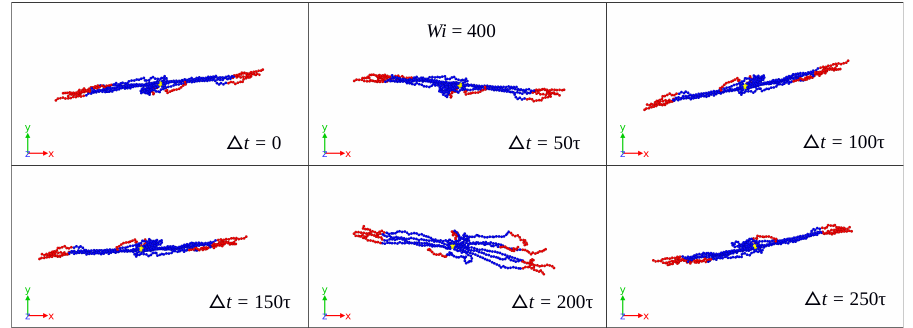
Figure 4. Time evolution of the (fixed) reference configuration in Eckart’s frame as seen in the laboratory frame for Case 1 and Wi =